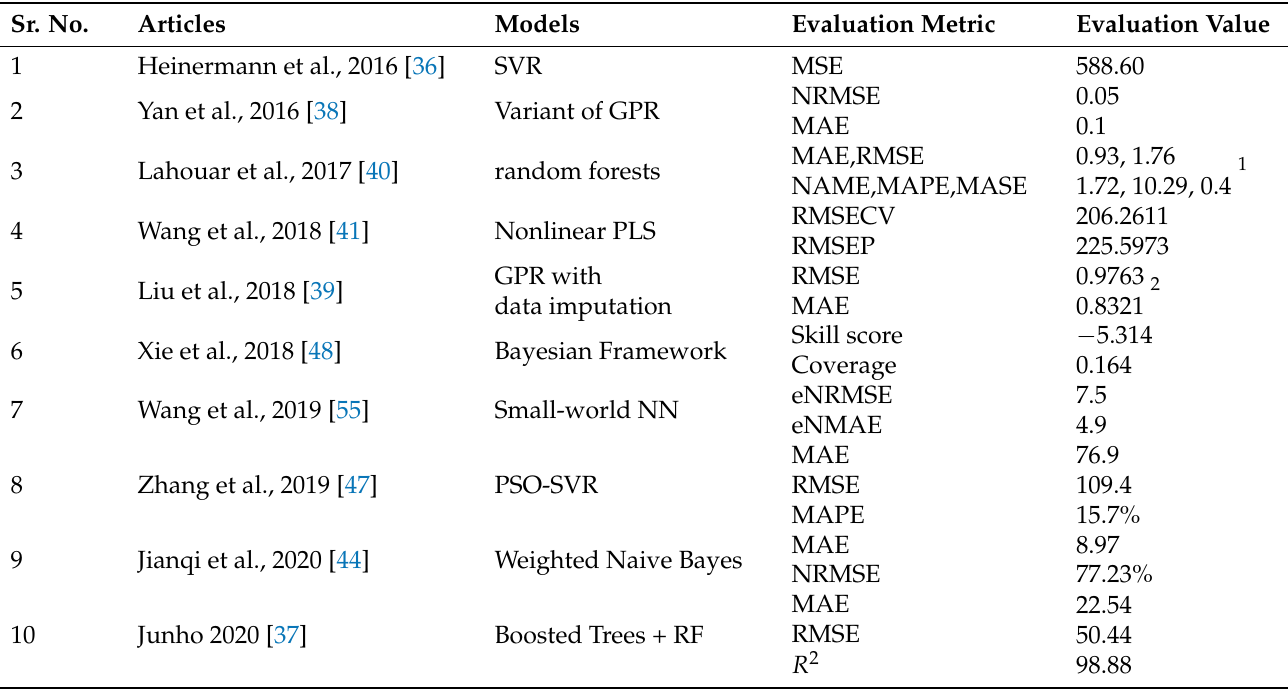
Table 6 list the details of the machine learning methods in short-term WPP. Table 6. Machine learning methods for short-term